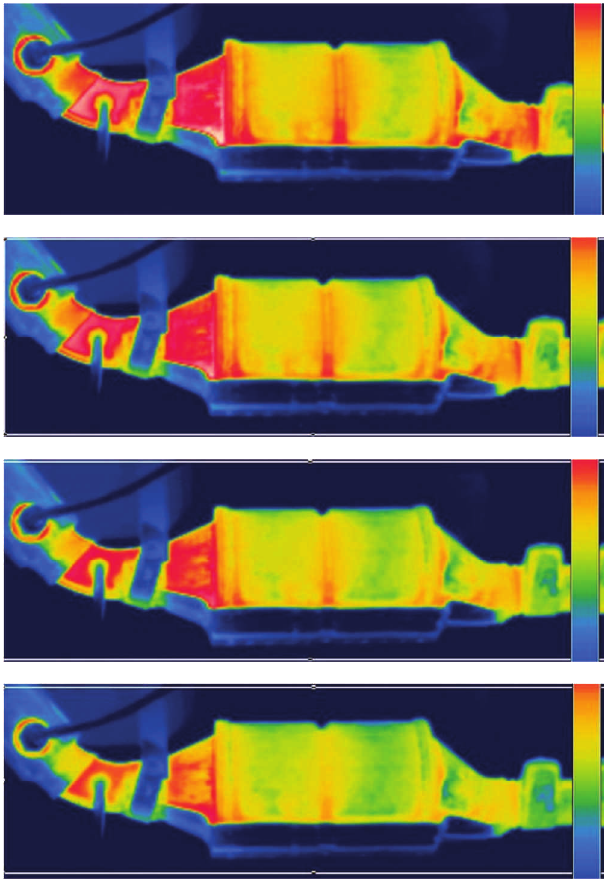
Fig. 6. Thermo-graphic images selected from the measurements – petrol supply, load: 40 Nm, 30 Nm, 20 Nm, 10 Nm